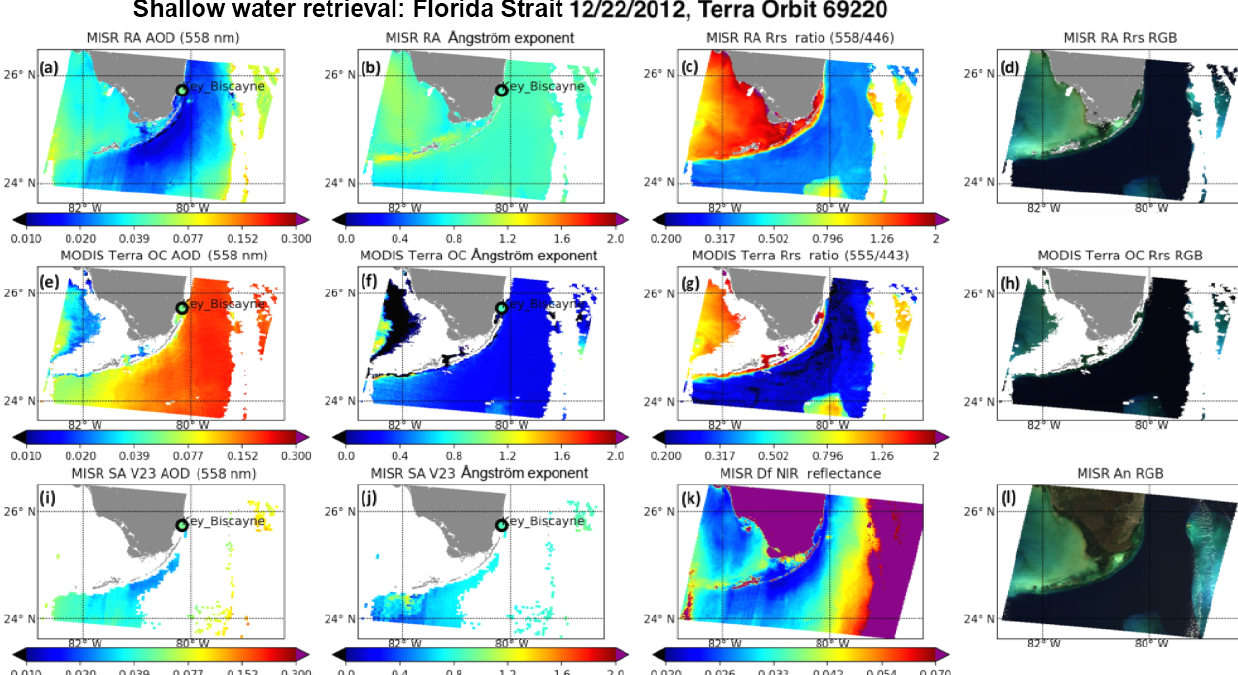
Figure 1. Example of MISR RA aerosol retrieval over shallow water. MISR imagery acquired on 22 December 2012, 16:07Z: Terra Or- bit 69220, blocks 70–71, over southern Florida and the Florida Strait. MISR RA 558nm (green AOD), MODIS-Terra ocean color (OC) AOD (558nm, extrapolated using MODIS ANG), and the MISR version 23 SA AOD (558nm) are presented in the first column (panels a , e , i , respectively). Plots of MISR RA ANG, MODIS-Terra OC ANG, and MISR version 23 SA ANG are provided in the second column (panels b , f , j ). MISR RA R rs ratios (558nm / 446nm), MODIS OC R rs ratios (555nm / 443nm), and the MISR 70.5 ◦ forward-viewing near-infrared (NIR) reflectance are provided in the third column (panels c , g , k , respectively). Brightness-enhanced true-color images of MISR RA R rs , MODIS-Terra OC R rs , and a MISR nadir context image (Rayleigh corrected) are presented in the fourth column (panels d , h , l , respectively). Where available, AERONET data are embedded in the plots as shaded circles matched to the scale of the relevant color bar.